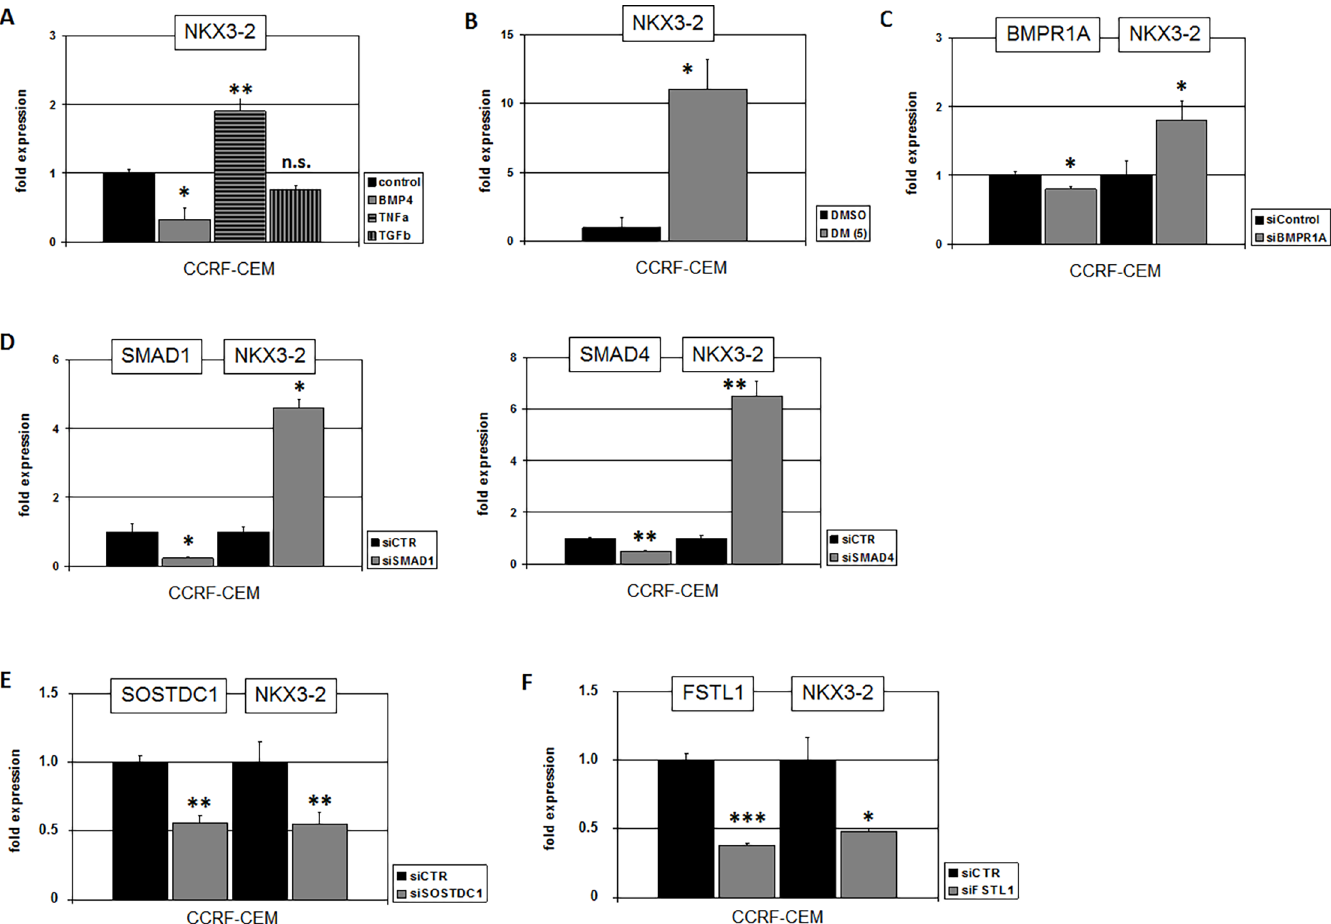
Fig 4. Regulation of NKX3-2 by the BMP-pathway. (A) RQ-PCR analysis of NKX3-2 in CCRF-CEM after treatment with BMP4, TNFa and TGFb demonstrates suppression by BMP-signalling and activation by TNFa-signalling. (B) RQ-PCR analysis of NKX3-2 in CCRF-CEM after treatment with BMP-receptor inhibitor DM supported gene suppression by BMP-pathway. (C) SiRNA-mediated knockdown of BMP-receptor 1A resulted in elevated expression of NKX3-2. (D) SiRNA-mediated knockdown of SMAD1 (left) and of SMAD4 (right) resulted in elevated expression of NKX3-2. SiRNA-mediated knockdown of SOSTDC1 (E) and of FSTL1 (F) resulted in reduced expression of